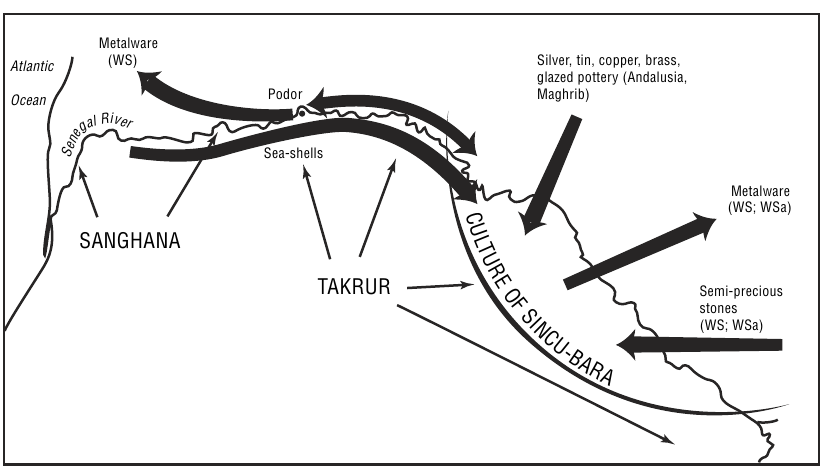
Figure 22 – Schematic representation of Sincu-Bara's PGNs (11t–13t